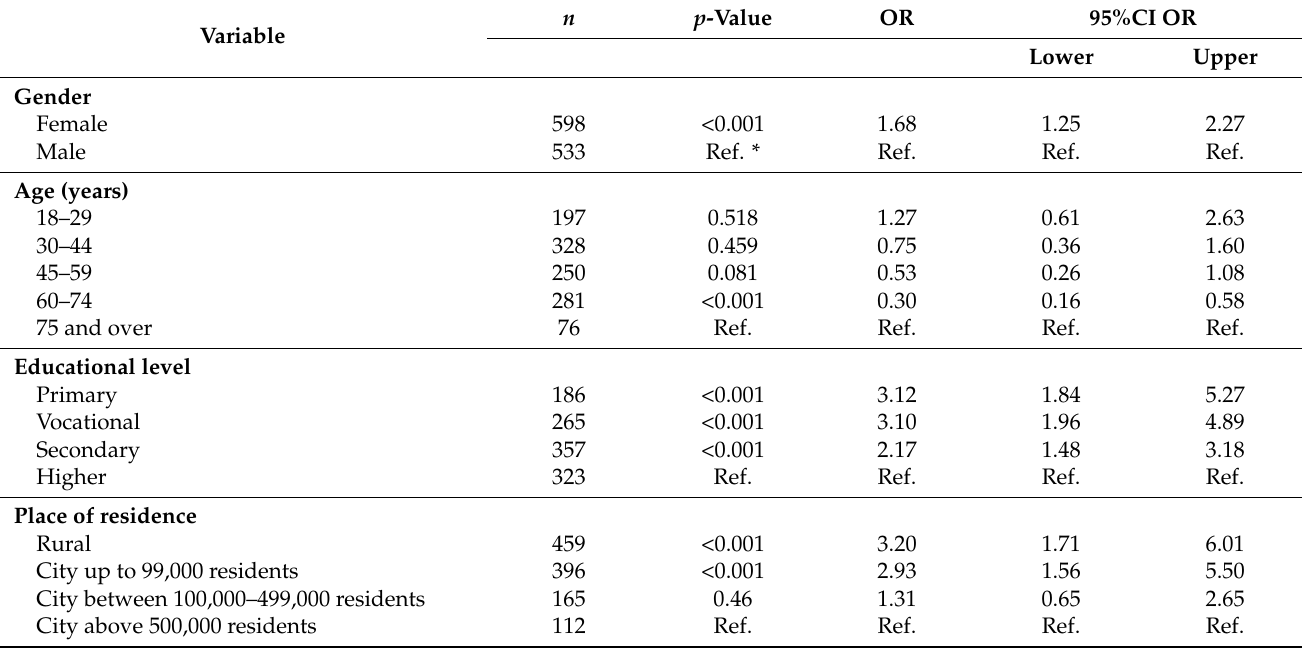
Table 3. Sociodemographic factors associated with a lack of willingness to vaccinate against COVID-19—the multivariate logistic regression